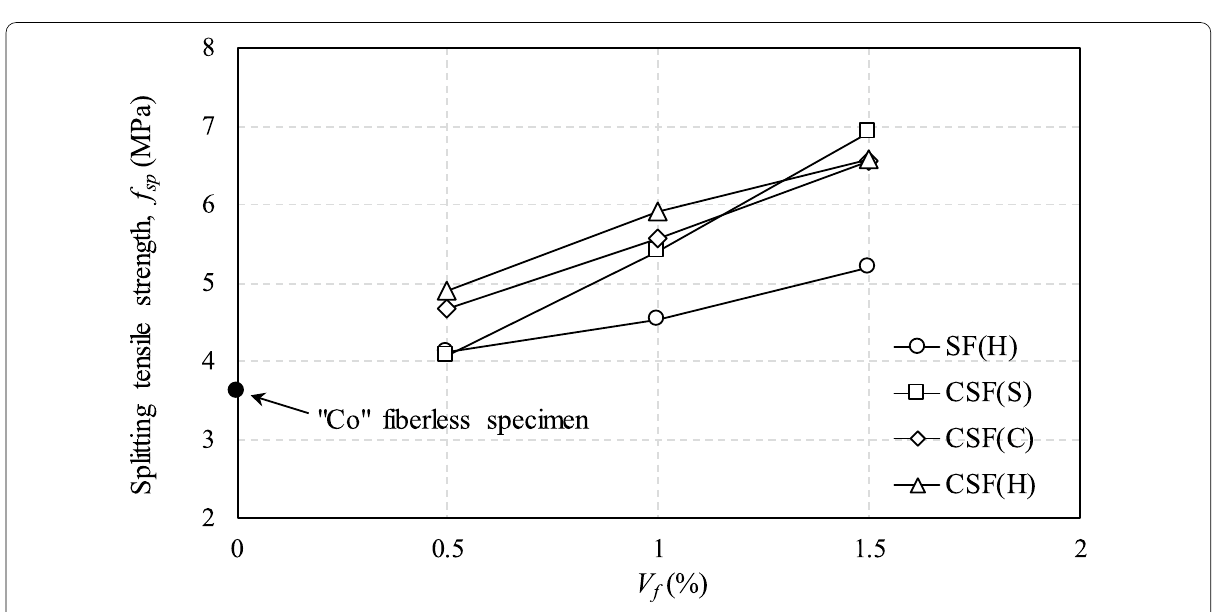
Fig. 7 Splitting tensile strength according to volume fraction of